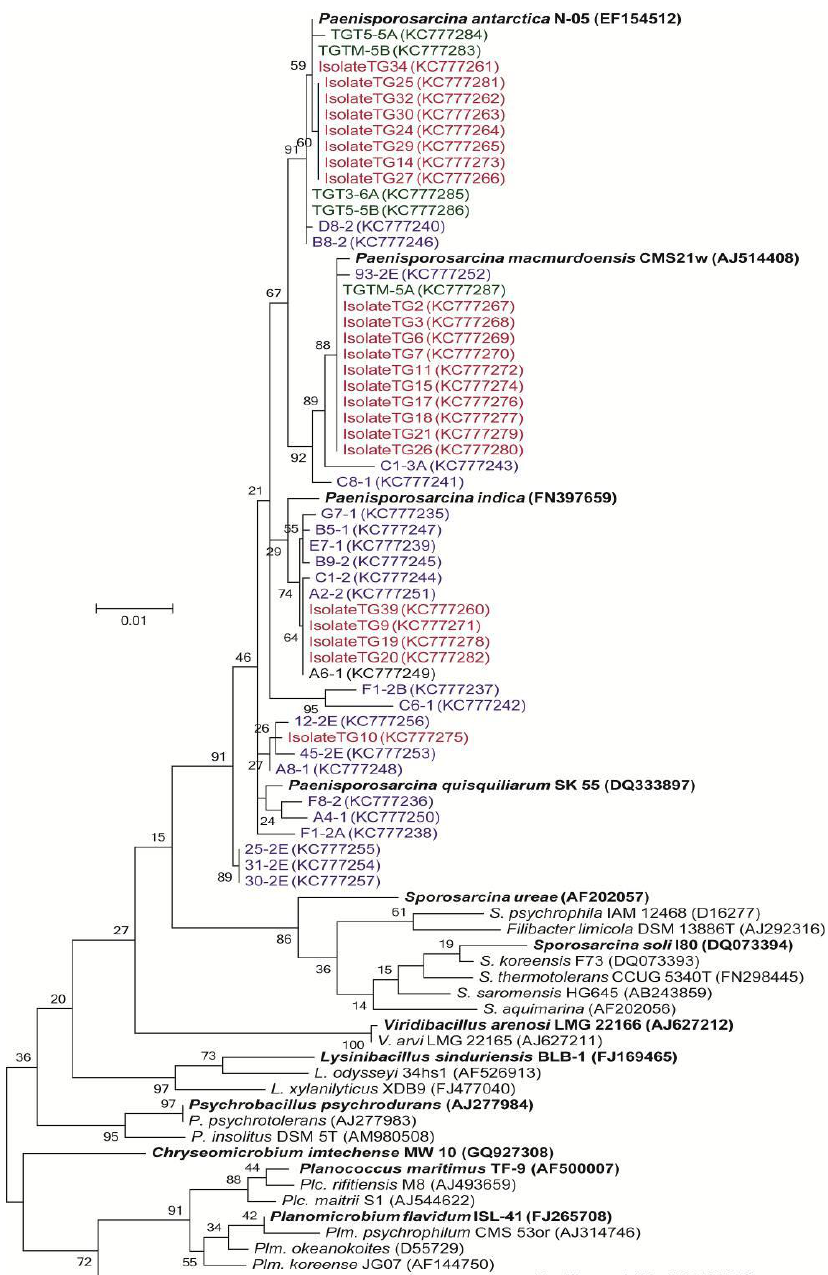
Figure 4. Phylogenetic tree of Paenisporosarcina -related clone and isolate 16S rRNA gene sequences using a Maximum Likelihood method based on the Jukes-Cantor model. The partial 16S rRNA gene sequences, corresponding to nucleotides 108 (cid:177) 1407 ( E. coli numbering), were aligned to the SILVA reference database (v. 113). After filtering gaps, the final alignment was based on 1,288 nucleotides. Isolate sequences are shown in red and cloned sequences are shown in blue. Isolates recovered from the 1999 samples are shown in green. The bootstrap consensus tree inferred from 1,000 replicates is taken to represent the evolutionary history of the taxa analyzed [44]. Branches corresponding to partitions reproduced in less than 50% bootstrap replicates are collapsed. The percentage of replicate trees in which the associated taxa clustered together in the bootstrap test is shown next to the branches. The scale bar represents the number of changes per nucleotide